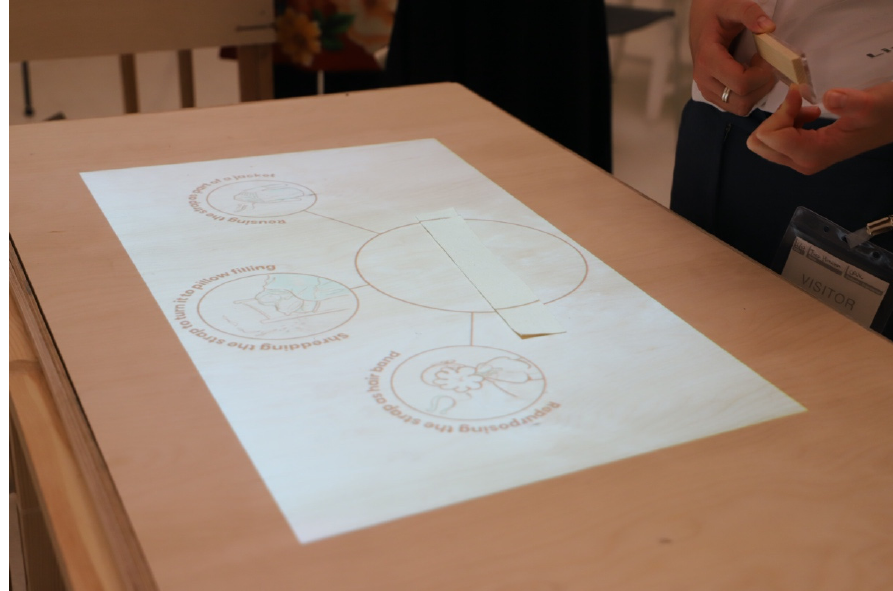
Figure 6. Material Futures. Figure 6. Materials Gym.